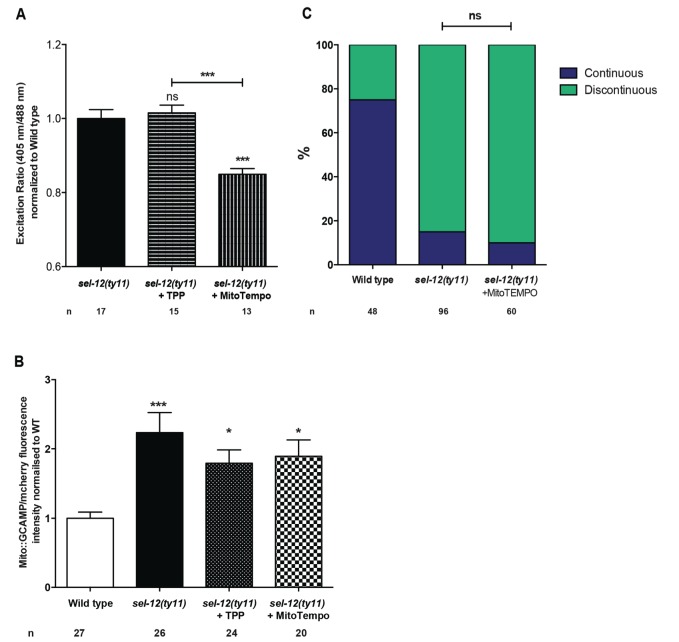
Mitochondrial disorganization in the mechanosensory neurons of sel-12 animals is not a direct result of elevated ROS levels.(A) Quantification of oxidized state of ALM neuronal mitochondria using zhsEx17 [Pmec-4mitoLS::ROGFP] treated with TPP or mitoTEMPO. (B) Quantification of mitochondrial Ca2+ using animals expressing mito::GCaMP6 and mCherry in their mechanosensory neurons (takEx415) treated with TPP or mitoTEMPO. (C) Quantification of ALM neuronal mitochondrial morphology in wild type and MitoTEMPO or vehicle treated day one sel-12(ty11) animals. Data are displayed with blue and green representing the percentage of animals displaying continuous and discontinuous mitochondrial morphology, respectively. ns p>0.05 (Chi-square test). n = number of animals analyzed per genotype. Mitochondrial analysis was done using transgenic animals expressing mito::GFP in mechanosensory neurons (jsIs609).10.7554/eLife.33052.038Figure 9—figure supplement 1—source data 1.Raw data for Figure 9—figure supplement 1.